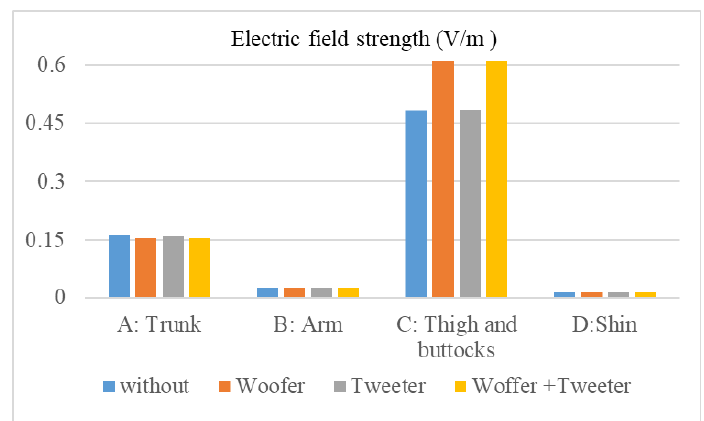
Figure 8. Maximum electric field strength (V/m) in different parts of the driver model in the CFRP vehicle for four scenarios (without the loudspeaker, with only the woofer, with only the tweeter, and with woofer and tweeter).